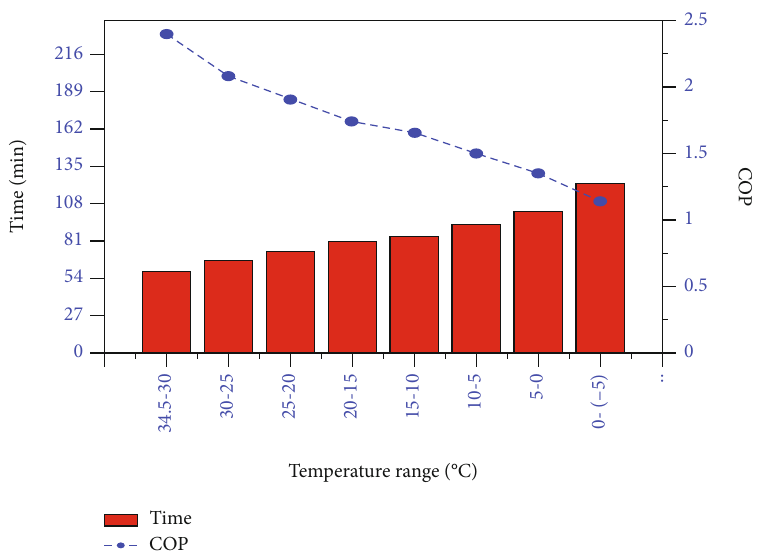
Figure 6: Time duration of HEF temperature reduction for every 5 ° C drop and corresponding COP of VCR.